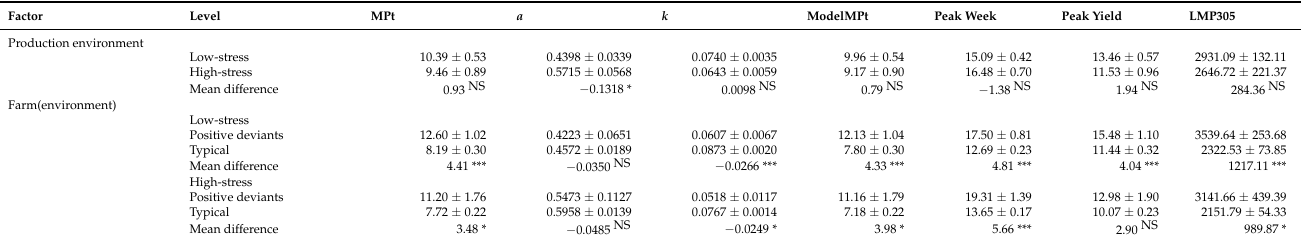
Table 3. Means (LSMEANS ± SE) of lactation curve parameters for Ayrshire cows managed in pos-itive deviants and typical farms nested within low- and high-stress production environments. Factor Level MPt a k ModelMPt PeakWeek PeakYield